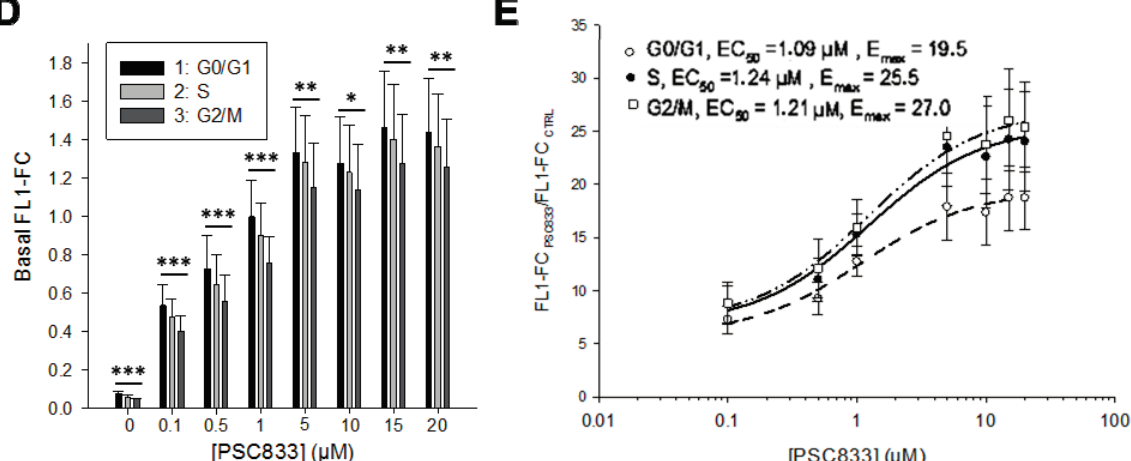
Figure 4. MCF-7/Doxo cells exhibit a cell cycle-dependent P-gp activity. ( A ) Cell cycle